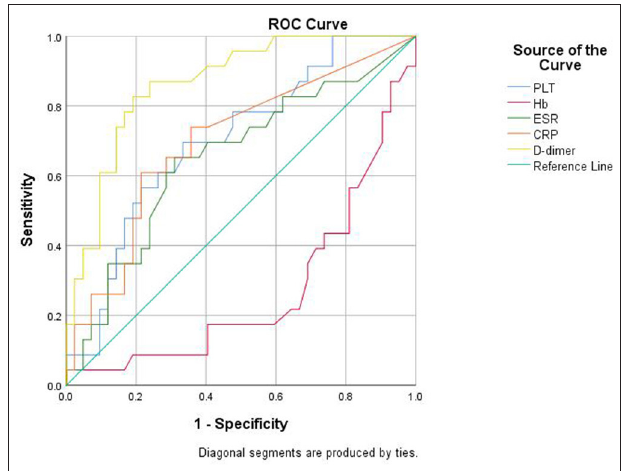
FIGURE 5 | Receiver operator characteristic (ROC) curve analysis of the biomarkers for detecting the gut inflammation in patients with SpA.